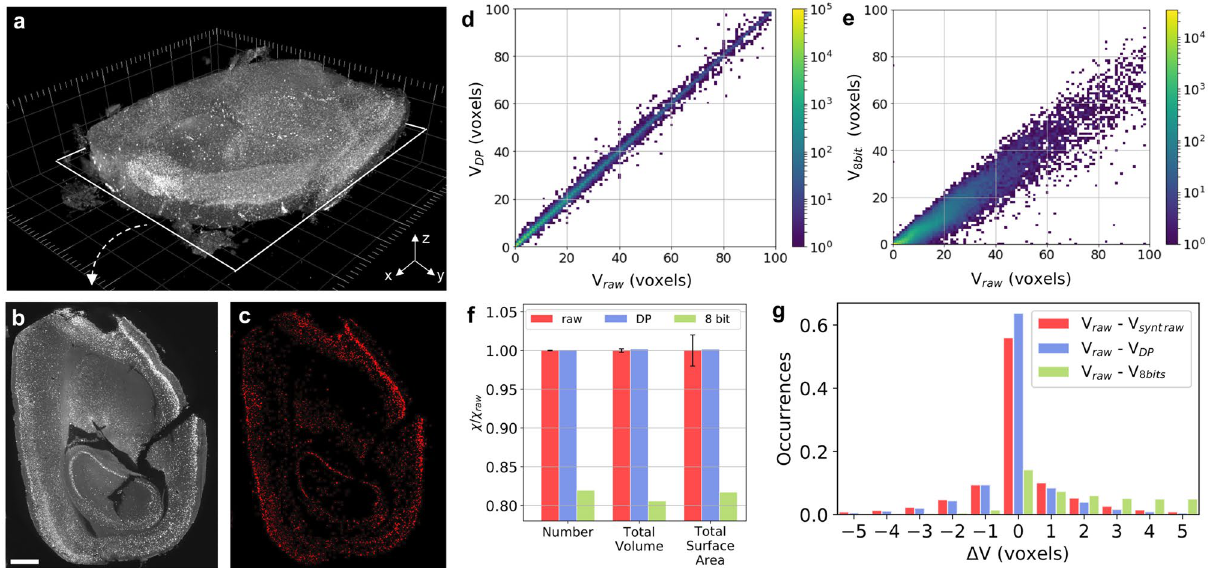
Figure 3. Statistical distortions induced by compression in 3D segmentation tasks in LS microscopy. ( a ) 3D LS image composed of 550 slices from a portion of a mouse brain obtained after c-fos staining performed to identify neuronal nuclei (1 voxel = 5.26 μm × 5.26 μm × 5 μm = 138 μm 3 ). ( b ) Single slice of the 3D image (scale bar: 1 mm) ( c ) Corresponding segmentation mask. ( d,e ) 2D histogram comparing the volume of the same objects in the raw (V raw ) and the 7.3:1 DP 3D compressed image (V DP ) ( d ), as well as the 8-bit 3D image (V 8 bits ) ( e ). ( f ) Values of the parameters associated to the whole segmented image, such as the number of objects, total